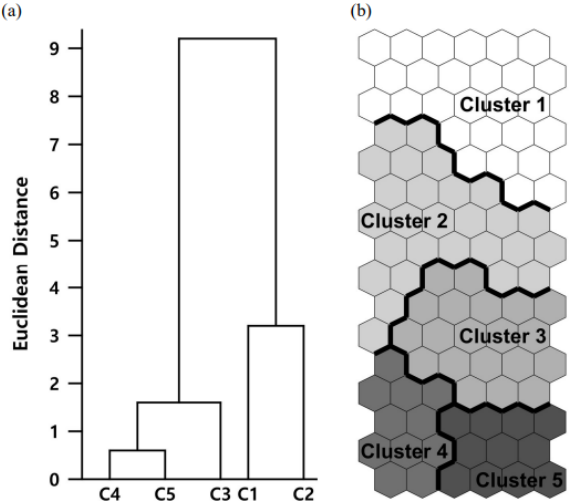
Figure 5. Structure of (a) dendrogram for five clusters and (b) SOM classifications in 96 neurons through the application of a 16 × 6 ma-